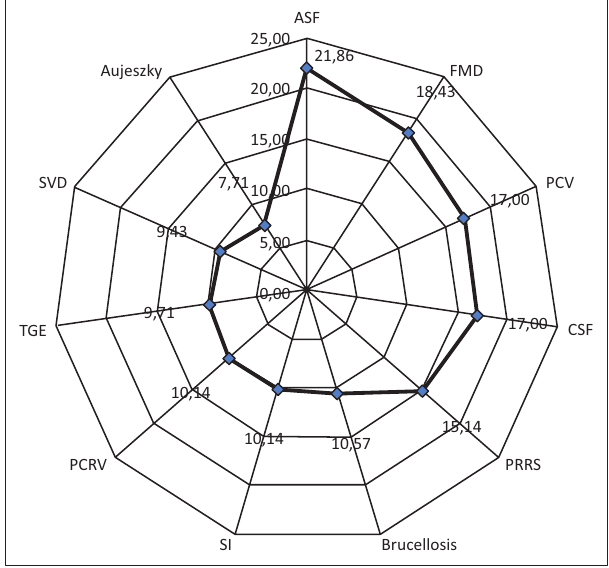
FIGURE 3: Radar chart (spider-web) of important pig diseases based on experts’